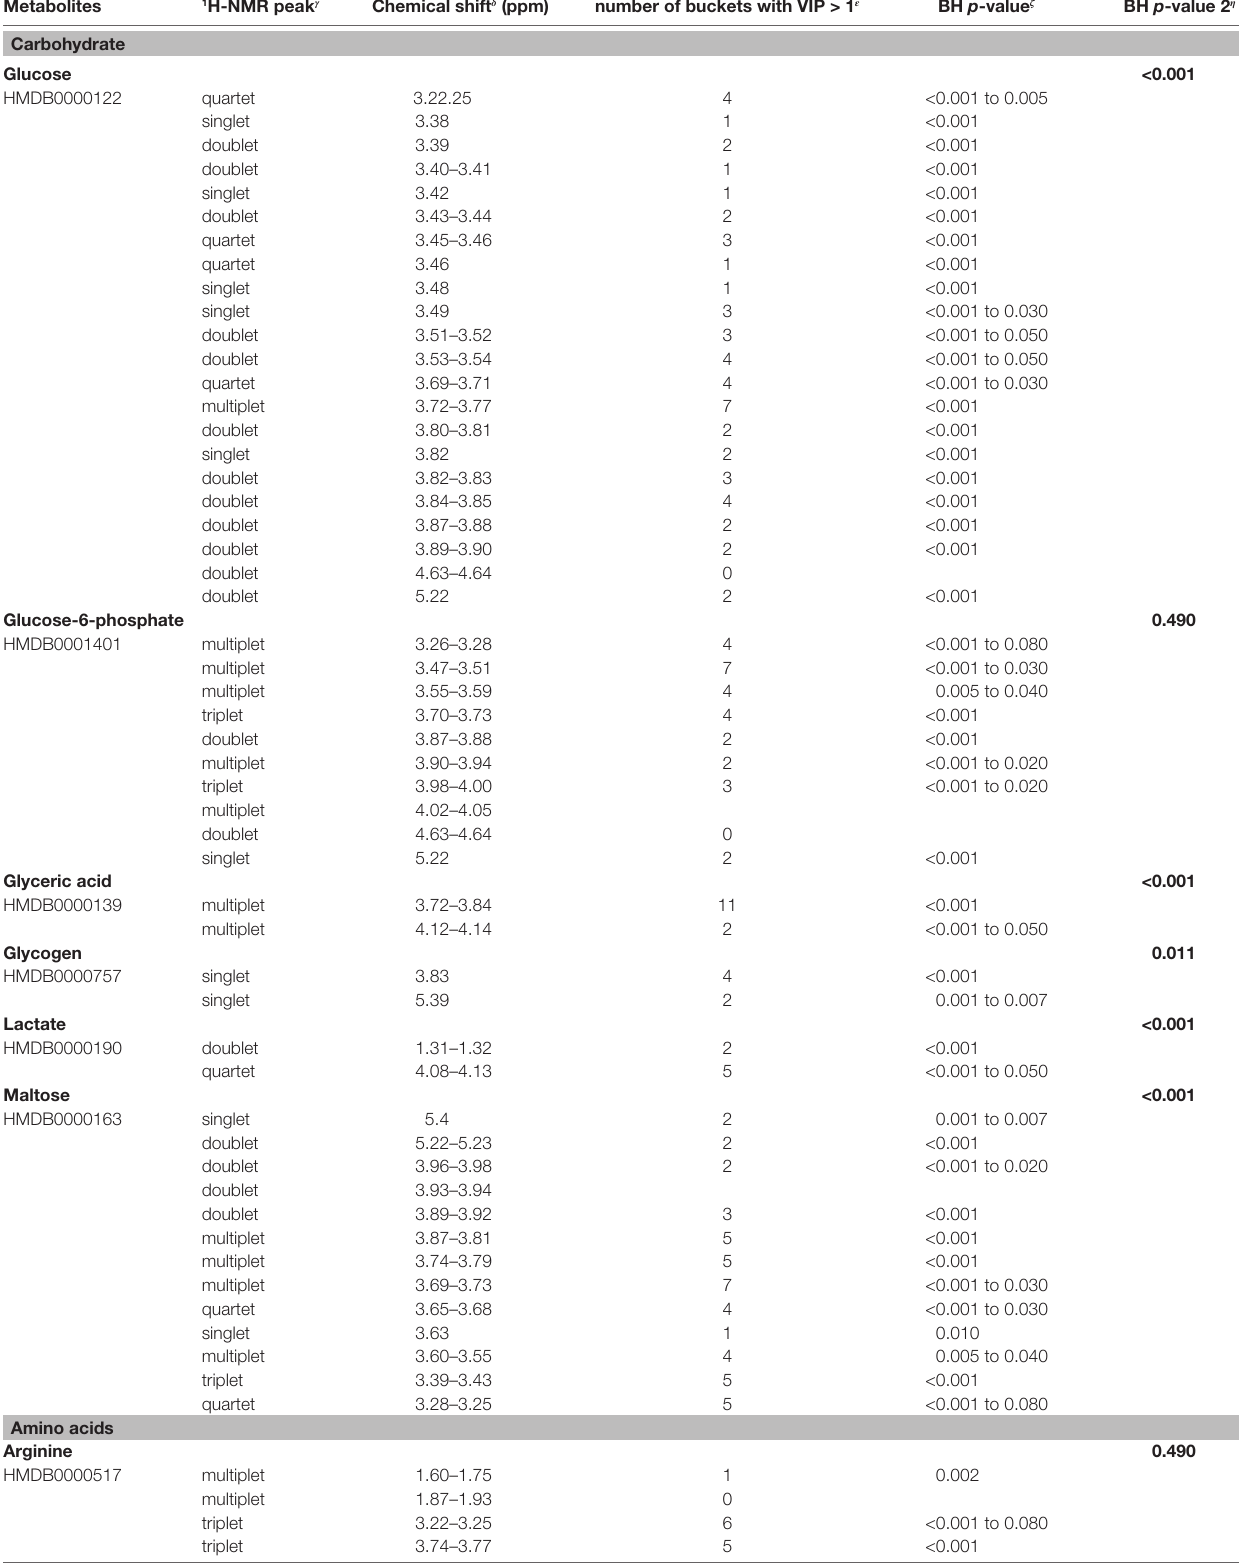
TABLE 3 | List of the 14 biomarkers of foie gras technological yield identified with the bucket method.